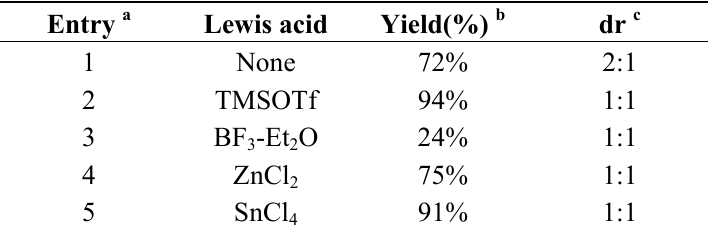
Table 1. Lewis acid-catalyzed Ireland-Claisen rearrangement of ester 10 . Entry a Lewis acid Yield(%) b dr c 1 None 72% 2:1 2 TMSOTf 94% 1:1 3 BF -Et O 24% 1:1 3 2 4 ZnCl 75% 1:1 2 5 SnCl 91% 4